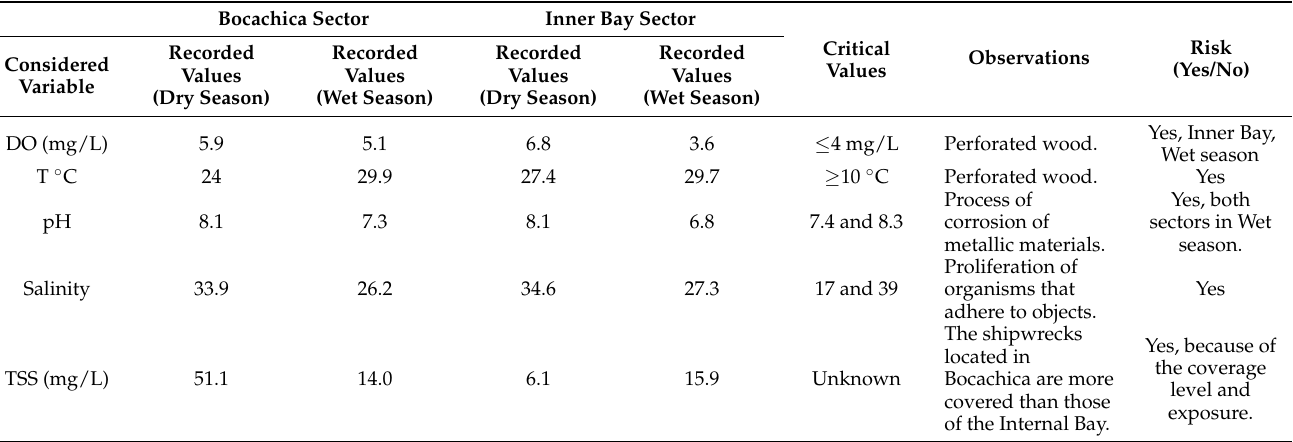
Table 7. Oceanographic variables and associated risk for the shipwrecks investigated in the Bay of Cartagena de Indias. Data recorded at 15 m water